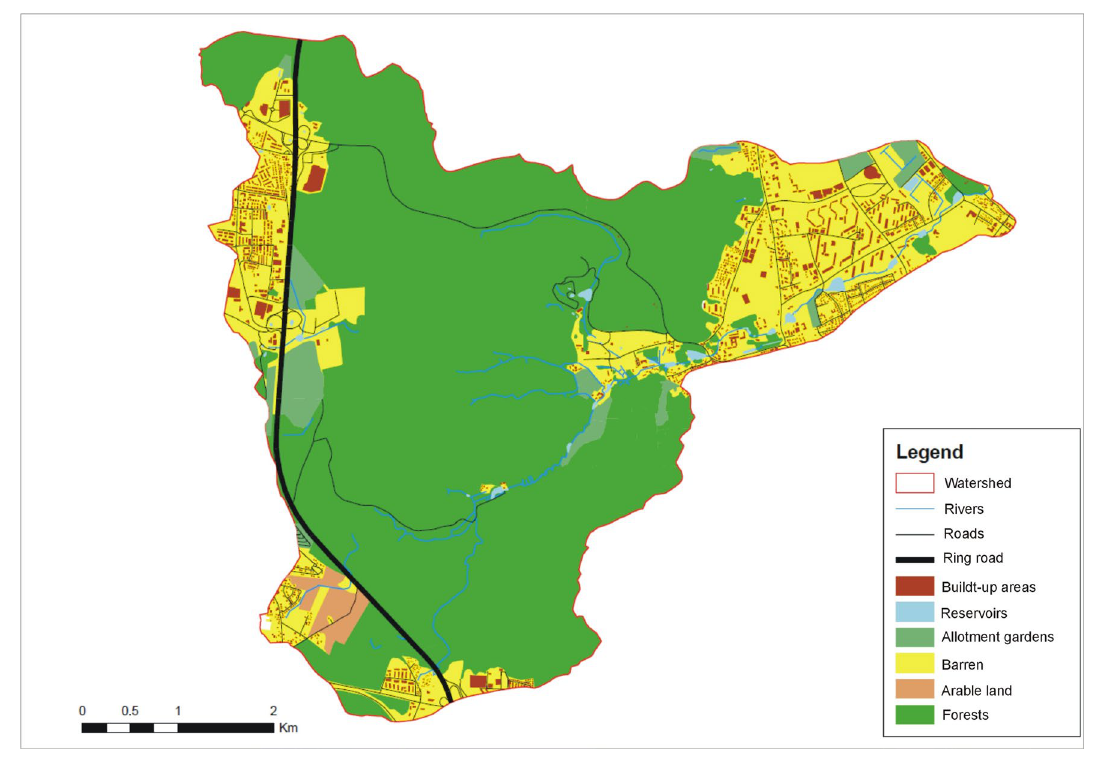
Fig. 11 Structure of land use in the Potok Oliwski catchment in 2018